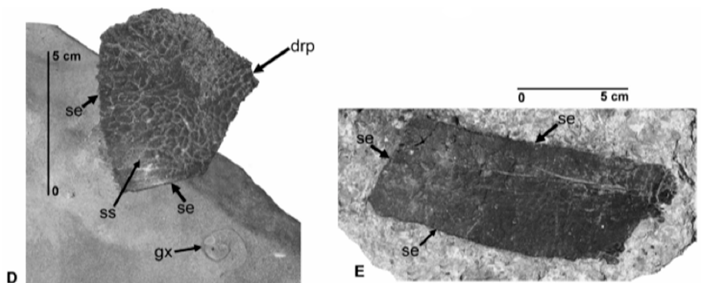
Figure 5. Turtle costals from the basalmost Midway Group lag deposit Hot Spring County, Arkansas.